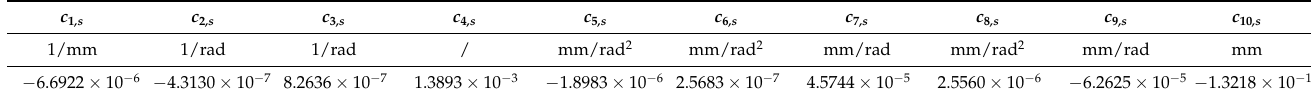
Table 3. The coefficients of the systematic error model of the LLS.